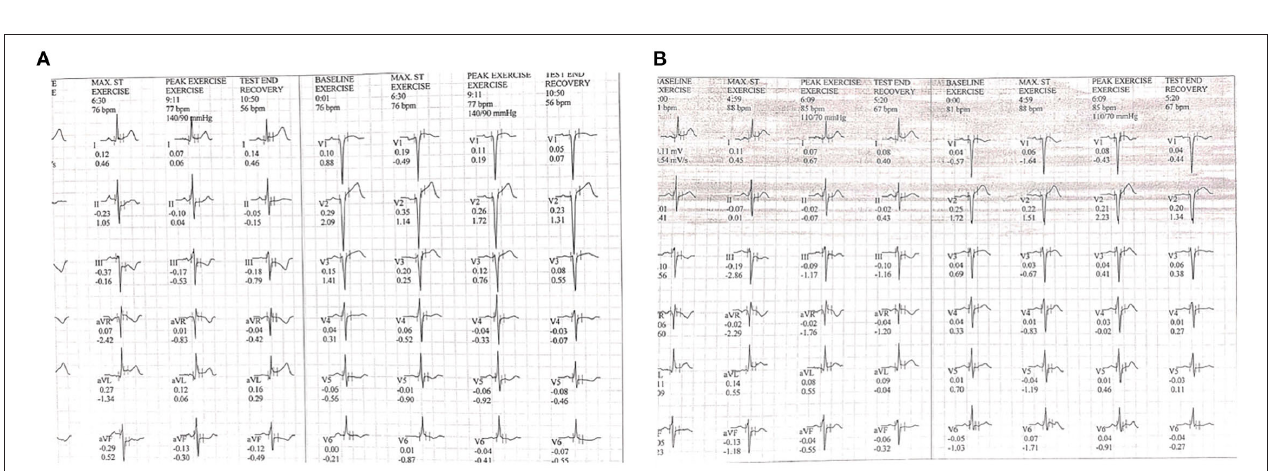
FIGURE 2 | ECG changes during treadmill test at (A) baseline and (B) after ESMR